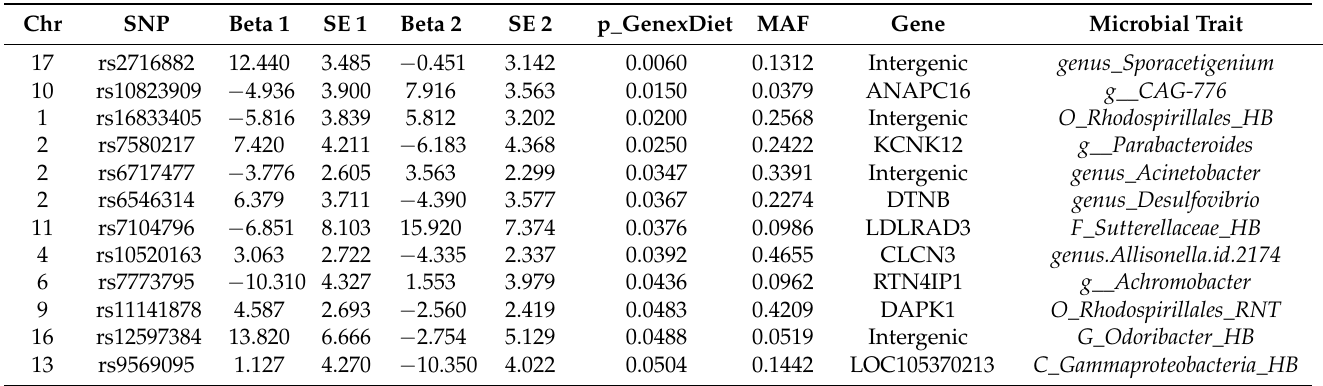
Table 4. Interaction between the top-ranked microbiota-related SNPs and Mediterranean diet on plasma fasting glucose in the whole population 1